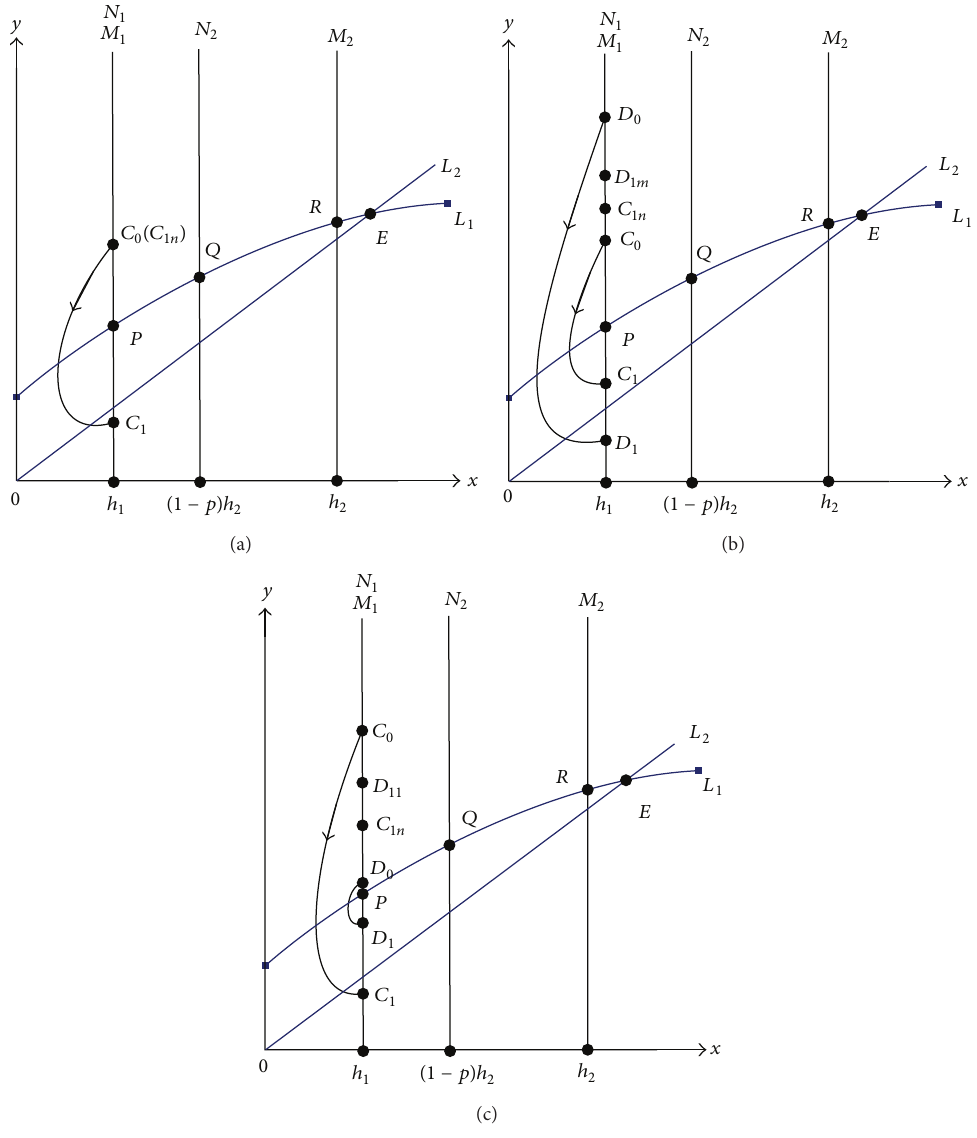
Figure 3: The orbit starting from the point 𝐶 0 on 𝑁 1